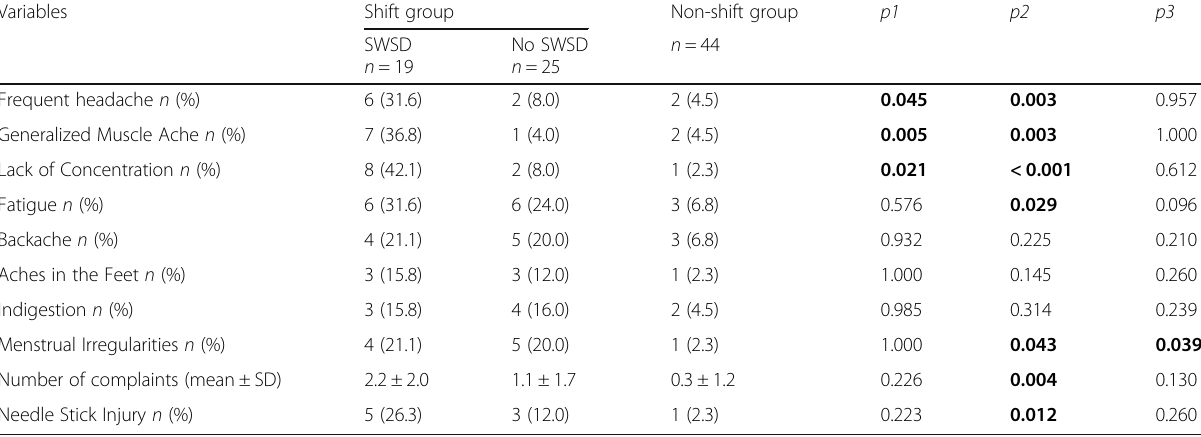
Table 2 Comparison of health complaints and occupational accident between the SWSD, No SWSD and non-shift Groups Variables Shift group